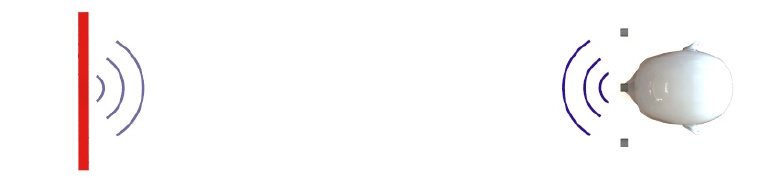
Figure 9. Concept of the